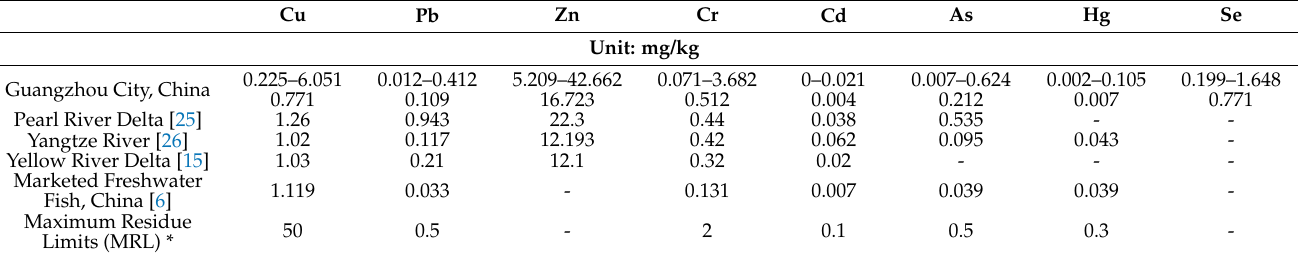
Table 1. Concentrations of metals in fish of this study and the available